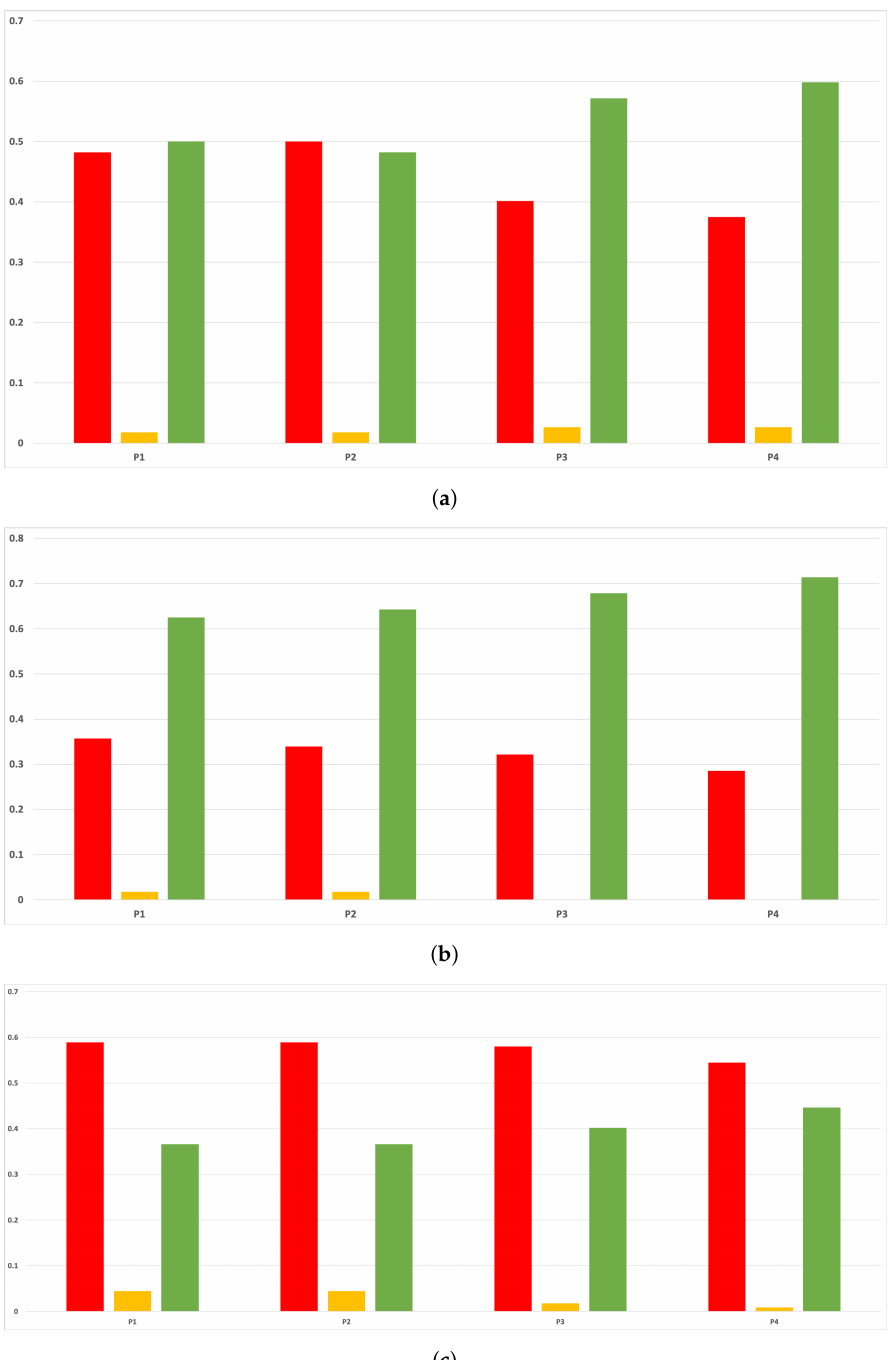
Figure 22. Experiment 2: consistency per partition (MCC and time complexity). ( a ) Rate of validity per partition in RF. In axis X, the partition of the dataset. In axis Y, the rate of RHOASo for each class of validity. ( b ) Rate of validity per partition in GB. In axis X, the partition of the dataset. In axis Y, the rate of RHOASo for each class of validity. ( c ) Rate of validity per partition in MLP. In axis X, the partition of the dataset. In axis Y, the rate of RHOASo for each class of